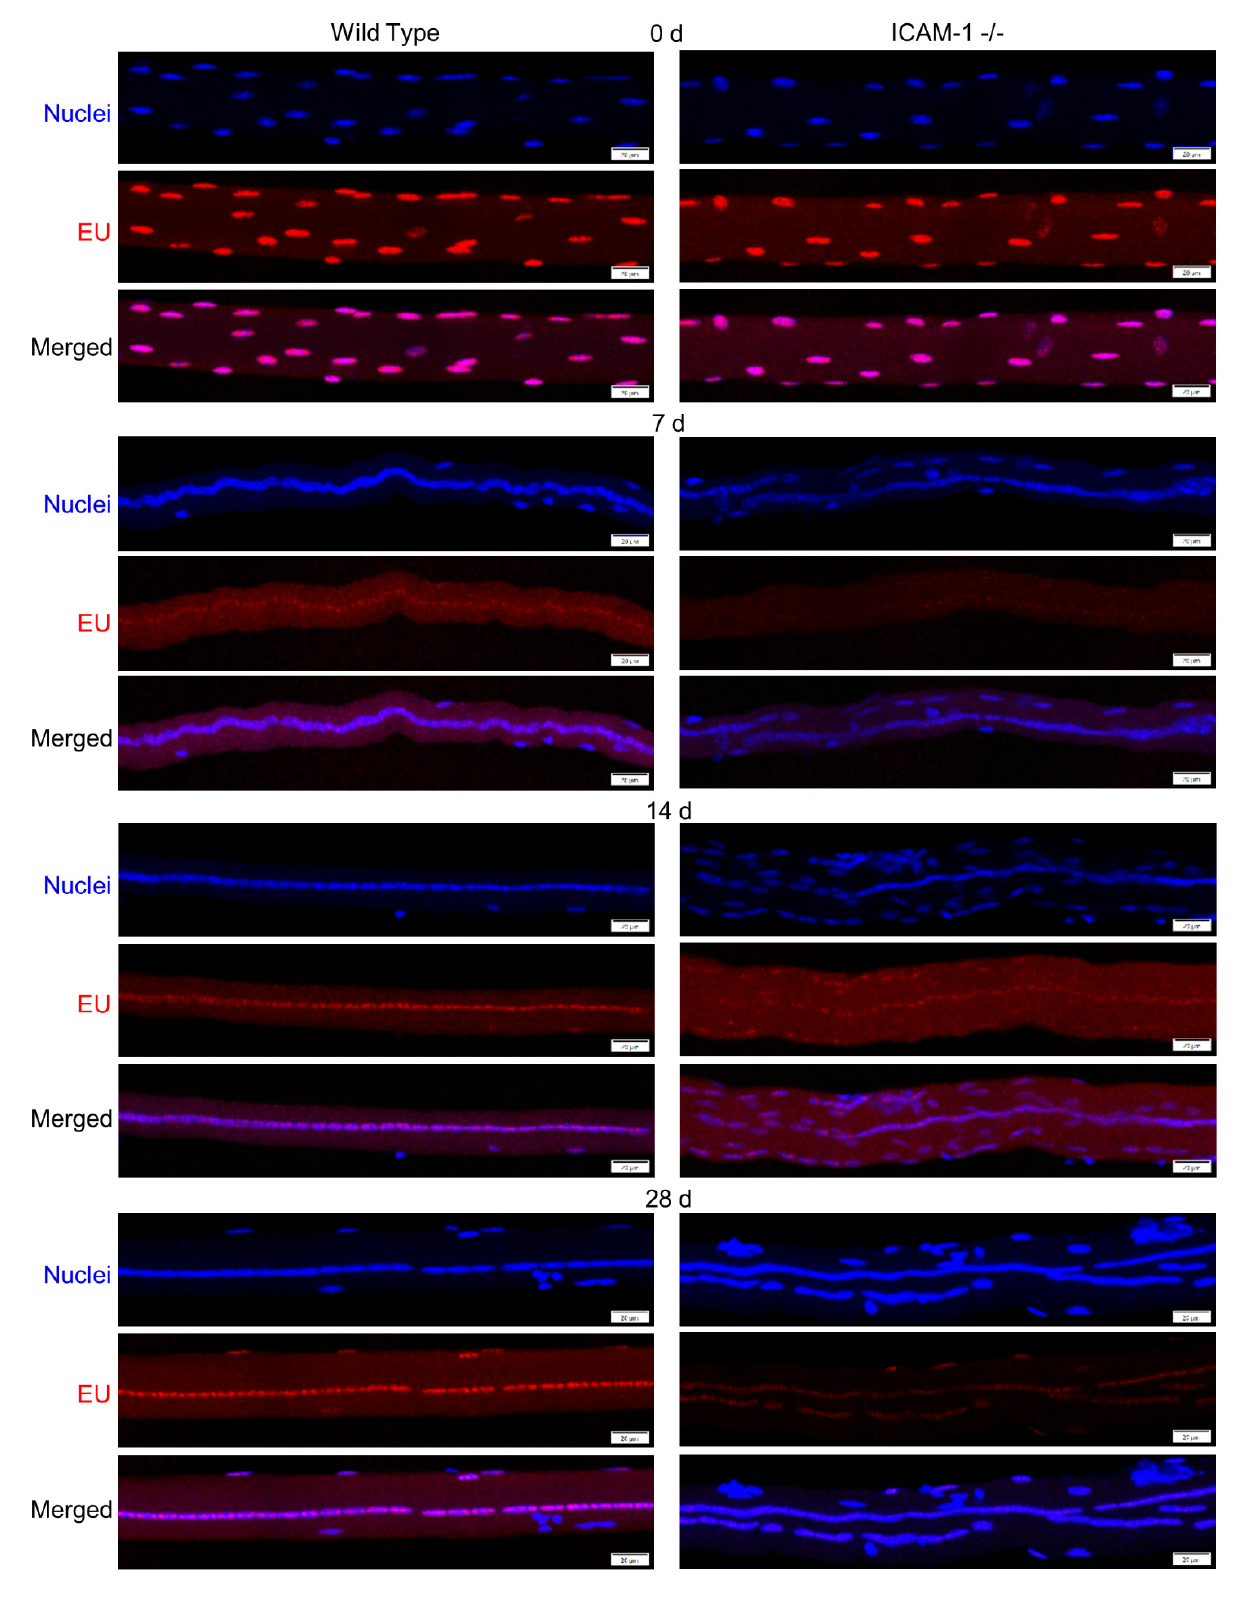
Figure 4. Detection of nascent RNA in myofibers before and during injury-induced muscle regenera- tion. Mice were administered 5-ethynyluridine (EU; red) and its presence detected within myonuclei (blue) of myofibers. Images are representative of responses observed 0, 7, 14, and 28 d post-injury. Scale bars = 20 μ m.